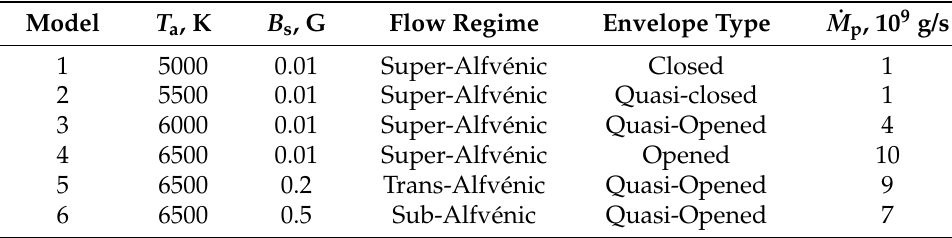
Table 1. Parameters and characteristics of the models: T a is the temperature of the upper atmosphere, B s is the magnetic field of the star, and ˙ M p is the mass loss rate of the